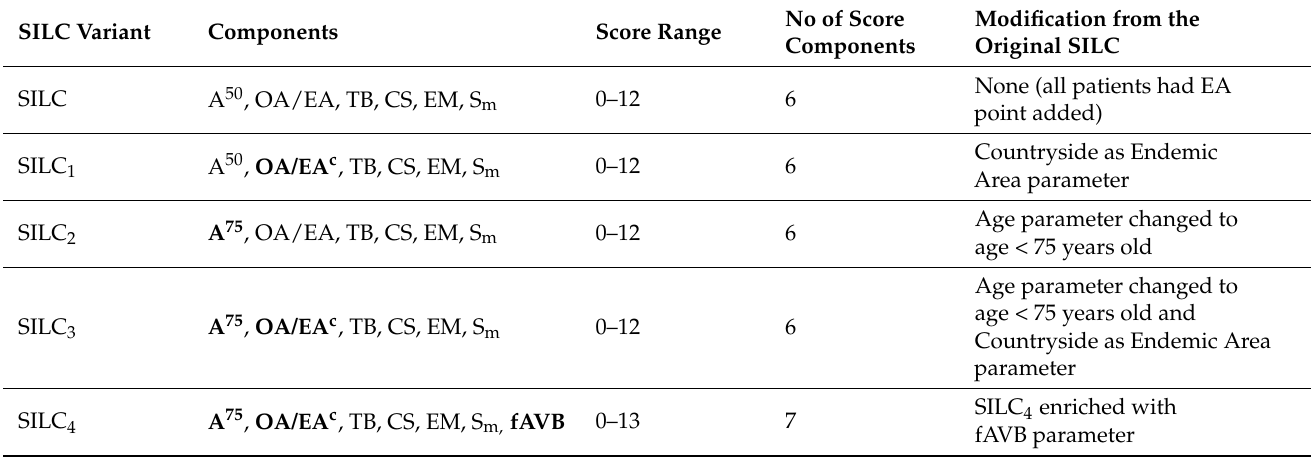
Table 2. Modifications of SILC